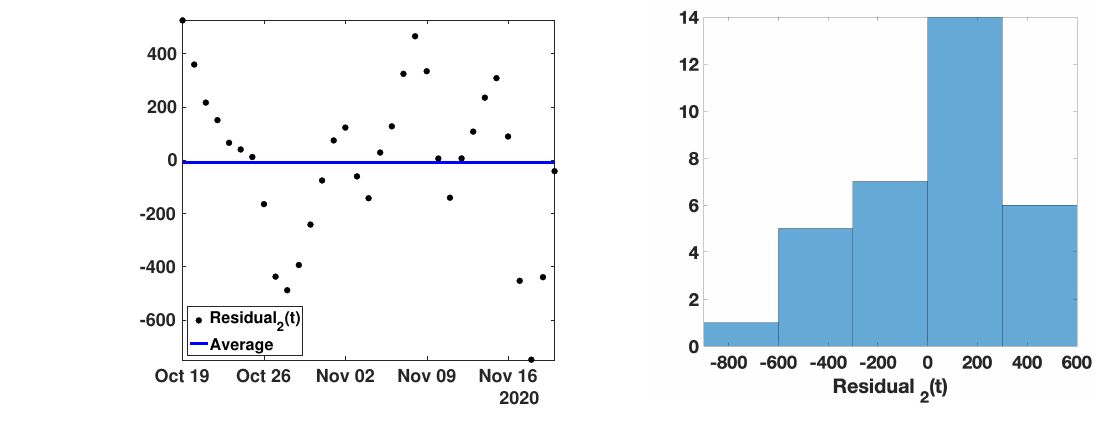
Figure A2. In this figure, we plot Residual 2 ( t )